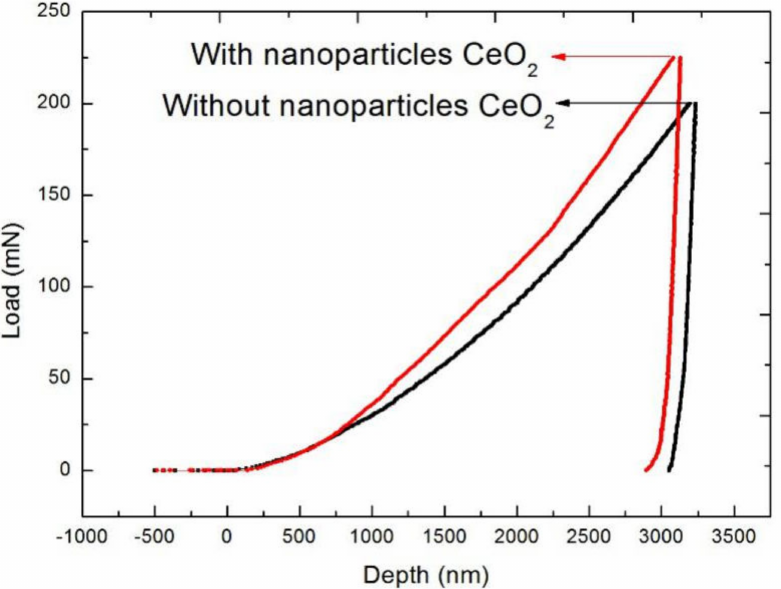
Figure 3. Bonded strength of interfacial